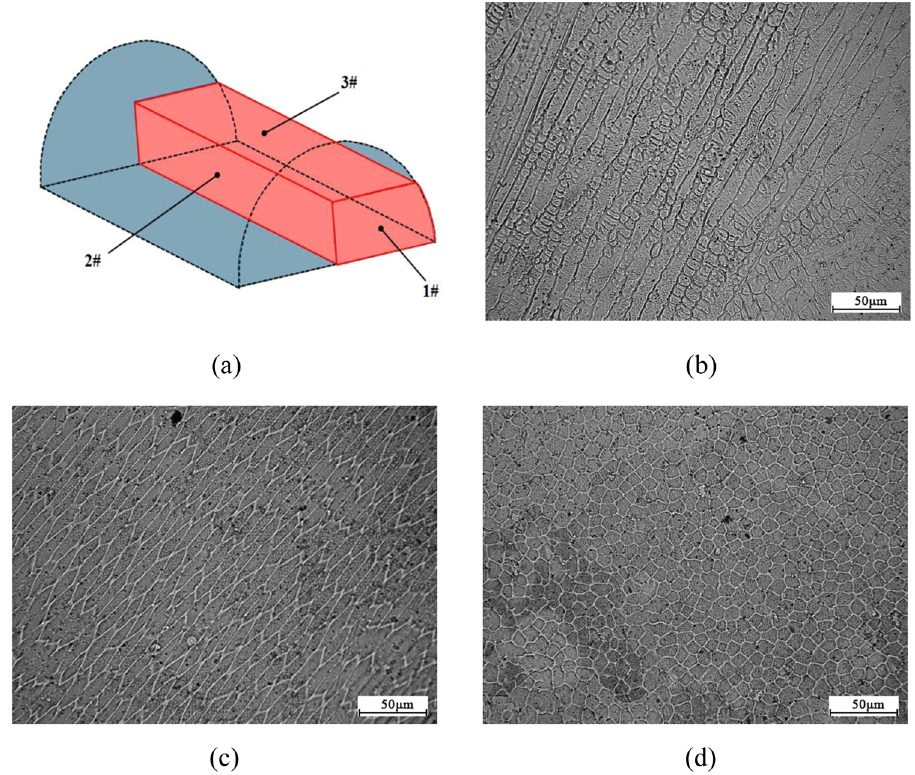
Figure 10: Microstructure of single - pass cladding layer on di ff erent observation surfaces: ( a ) sampling diagram; ( b ) observation surface #1; ( c ) observation surface #2; and ( d ) observation surface #3.